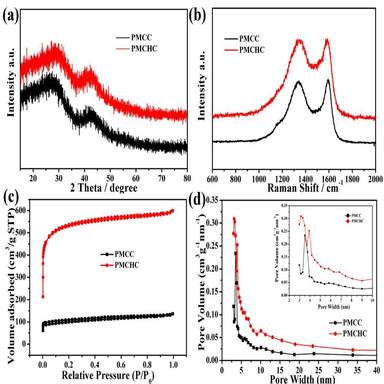
(a) XRD patterns of raw carbon material (PMCC) and activated carbon (PMCHC), (b) Raman spectra of PMCC and PMCHC, (c) The N2 adsorption/desorption isotherm of PMCHC, (d) its corresponding pore size distribution and its partial enlargement (inset).